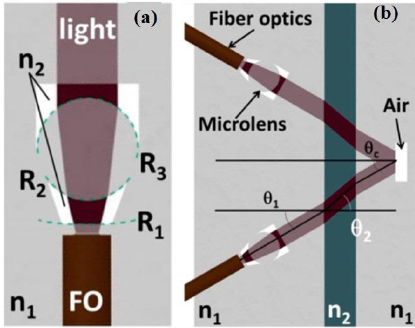
Figure 1. Graphic presentation of ( a ) the establishment and alignment of a collimating lenses and radius of curvature R (1 – 3) developed for the utilization with fiber optics of a distinct numerical aper- ture, and ( b ) the arrangement of various micro-optic constituents to adjust the light – specimen rela- tionship: Figure adapted from ref. [67] and requires the permission of Nature Protocols. Copyright 2011 Nature Publishing Group.